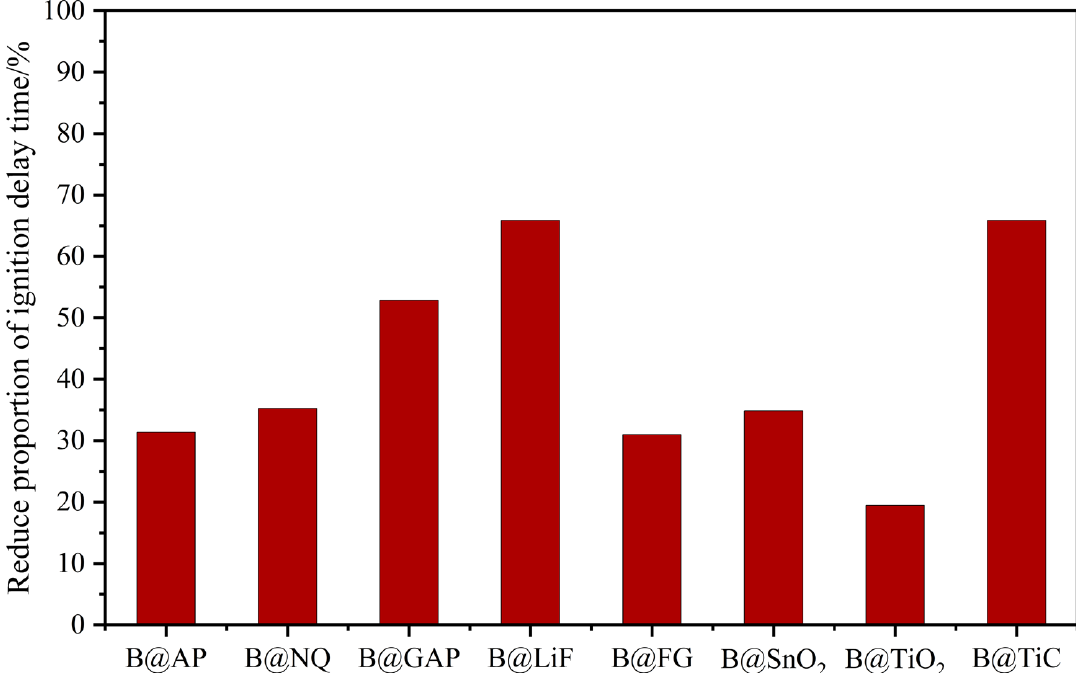
Figure 19. The reduction proportion of the ignition delay time [71,81,88,95,115,116,118] . Table 3. Combustion temperature and burning time of coated boron